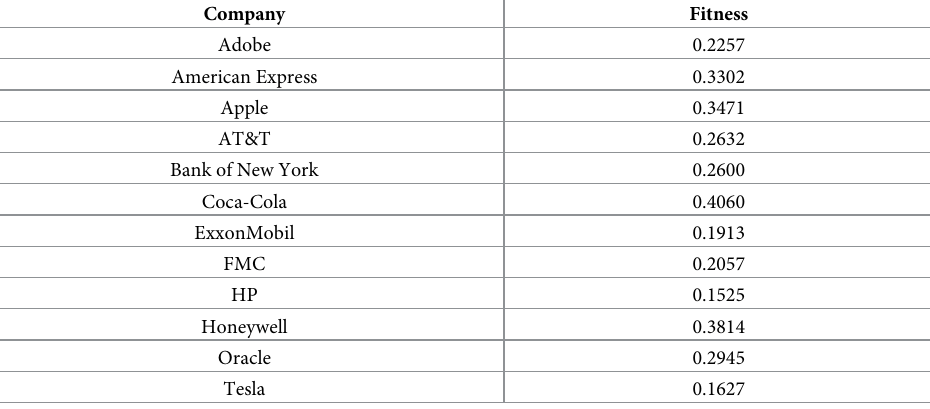
Table 3. Values of the fitness function for linear kernel LS-SVM algorithm run on various companies’